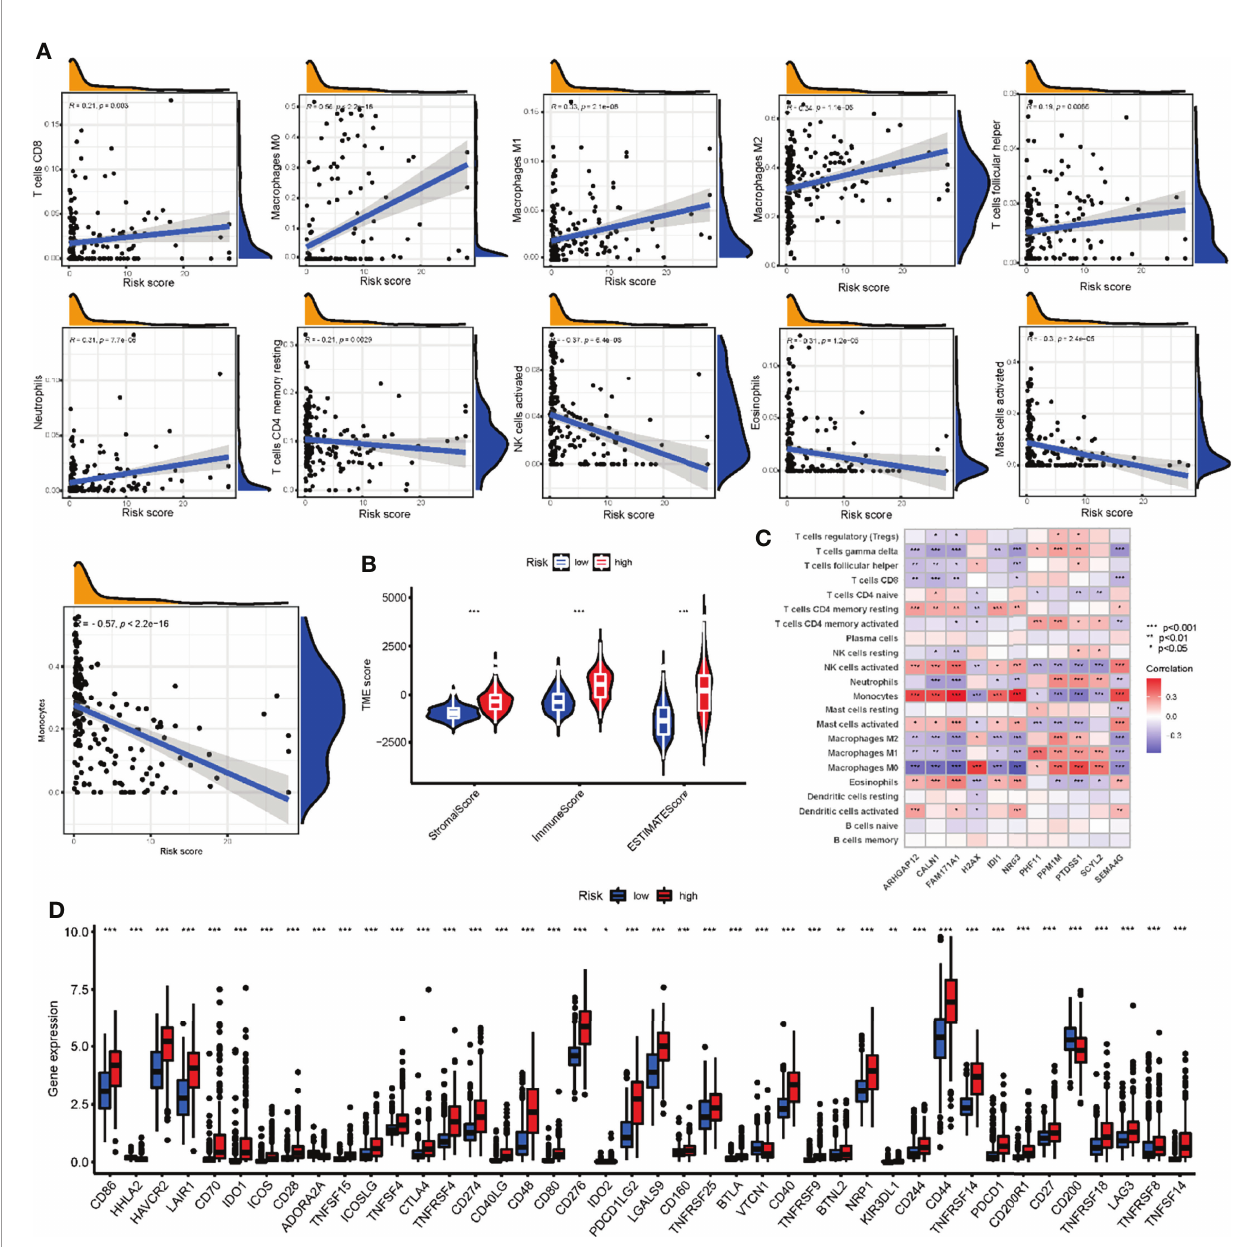
FIGURE 10 | Comparison of TME and checkpoints between the high- and low-risk groups. (A) Correlations between in fi ltrating immune cells and NRG_score. (B) Correlations between TME scores and NRG_score. (C) Correlations between the abundance of in fi ltrating immune cells and expression of NRGs in risk score model. (D) Expression of immune checkpoints between the two risk groups. TME, tumor microenvironment; NRGs, necroptosis-related genes. ***P<0.001, ** P<0.01,